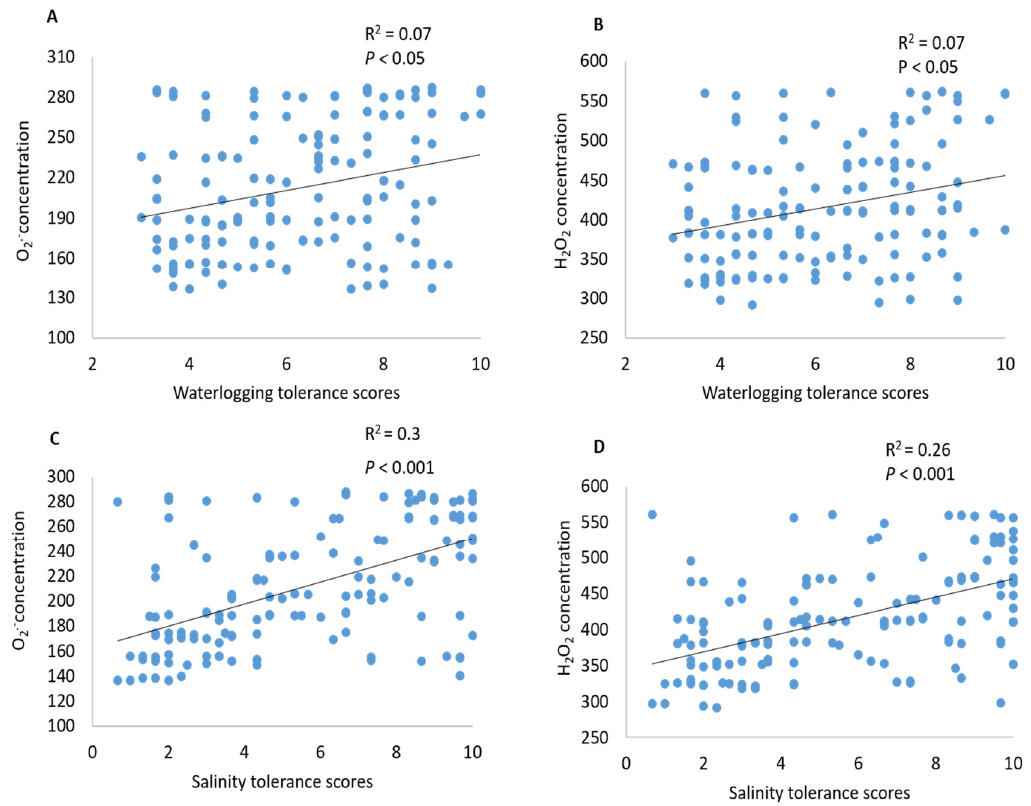
Figure 5. Correlations between ( A ) superoxide (O 2 •− ) radical concentration in mature zone and waterlogging tolerance scores, ( B ) hydrogen peroxide (H 2 O 2 ) concentration in elongation zone and waterlogging tolerance scores, ( C ) superoxide (O 2 •− ) radical concentration in mature zone and salinity tolerance scores, and ( D ) hydrogen peroxide (H 2 O 2 ) concentration in elongation zone and salinity tolerance scores.